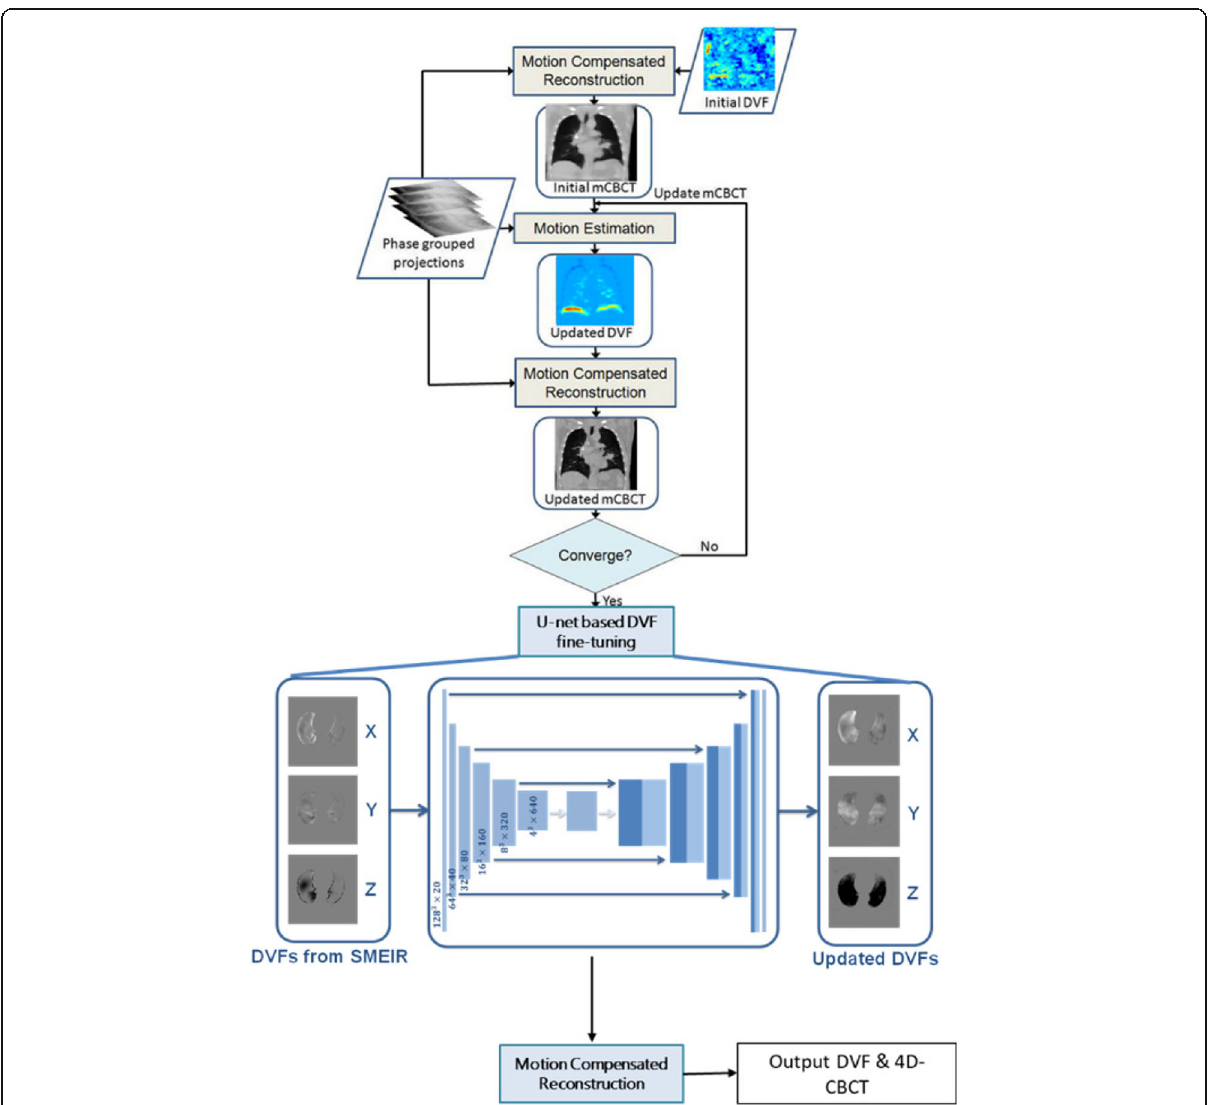
Fig. 4 Workflow of the SMEIR-Unet algorithm. Instead of feeding the DVFs into biomechanical modeling, SMEIR-Unet applies a U-net-based convolutional neural network to directly correct the output 2D-3D DVFs to boost their intra-lung accuracy. The corrected DVFs are output as the final inter-phase DVFs, and are applied in a final motion-compensated reconstruction step to generate the mCBCT at the reference phase, as well as the other 4D-CBCT phase images via the inverse DVFs. SMEIR-Unet: Simultaneous motion estimation and image reconstruction with U-net based DVF fine-tuning; DVF: Deformation-vector-field; 4D-CBCT: 4-Dimensional cone-beam computed tomography; mCBCT: Motion-compensated